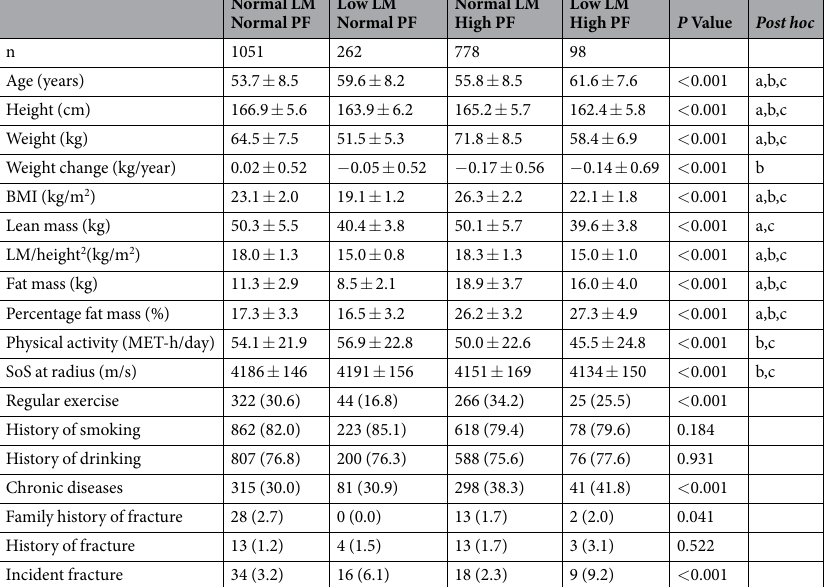
Table 1. Baseline characteristics of men according to body composition (n = 2,189). Values are means ± SD